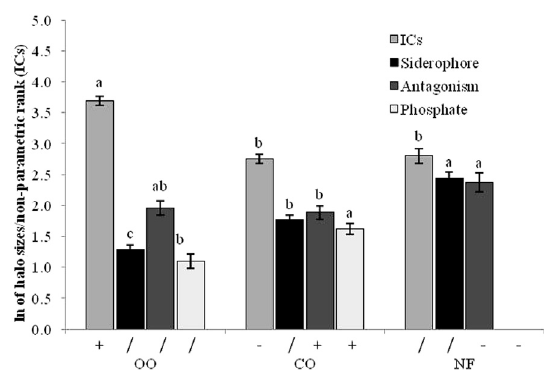
Figure 3 - Occurrence and activity of PGP traits of bacterial isolates from different management conditions. ANOVA-Tukey comparisons were made across each single PGP trait independently, so each statistical analy- sis compares bars with the same color. Bars show the activity of positive isolatesforeachPGPtrait;differentlettersshowsignificantdifferences.+, /,and-signsbelowthebarsshowtheassociationbetweenthesoilmanage- ment and the occurrence of the characteristic, as per adjusted residue anal- ysis: + = excessive number of bacteria displaying that characteristic in that condition; - = less bacteria then expected displaying that characteristic in that condition; / = number of isolates displaying that characteristic in that condition falls within expected range. OO = Organic Orchard, CO = Con- ventional Orchard, NF = Native Field. The scale is the natural log value of original values (in mm) for siderophores production, phosphate solubilization and antagonism assays. ICs production is in mg mL -1